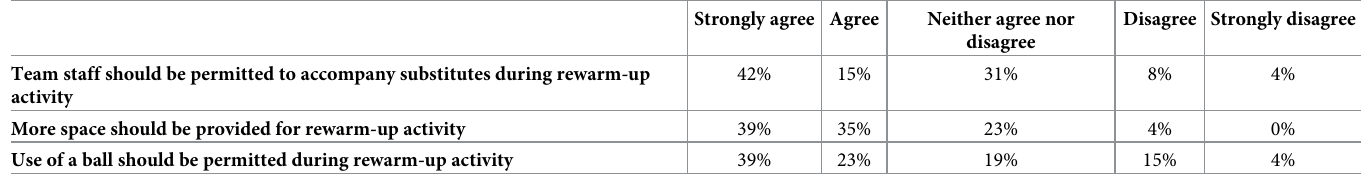
Table 3. Physical practitioner responses to statements regarding regulations governing rewarm-up activity performed whilst the match is underway (n =